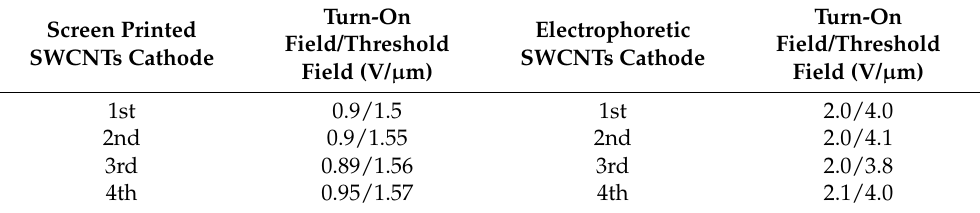
Table 1. Repetition tests of the screen printed and electrophoretic SWCNT